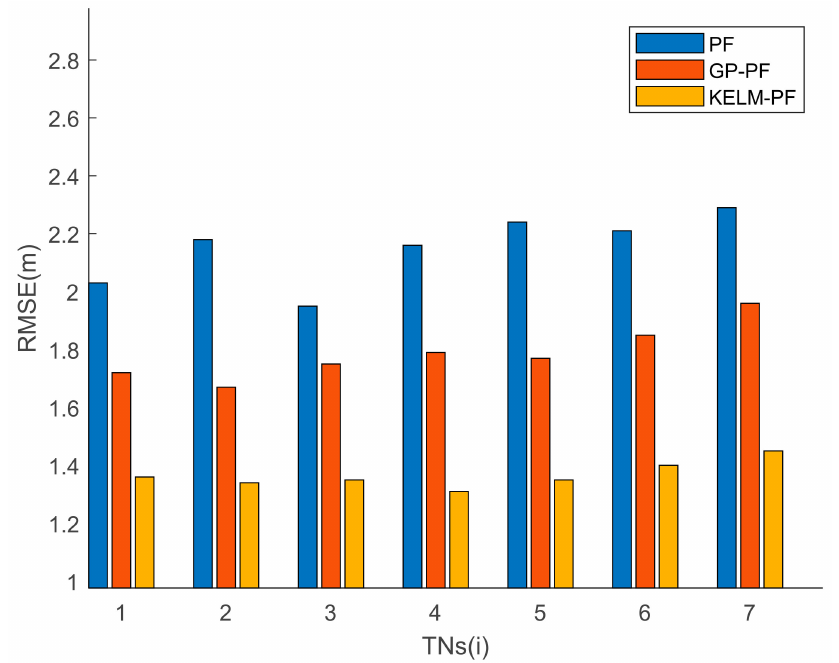
Figure 6. Positioning accuracies of different algorithms in the